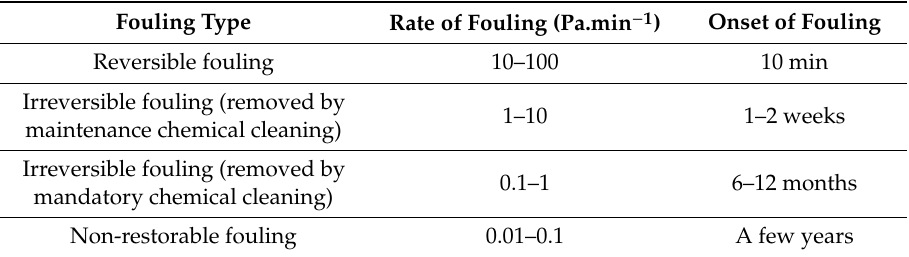
Table 1. Onset of various fouling of membrane in a membrane bioreactor